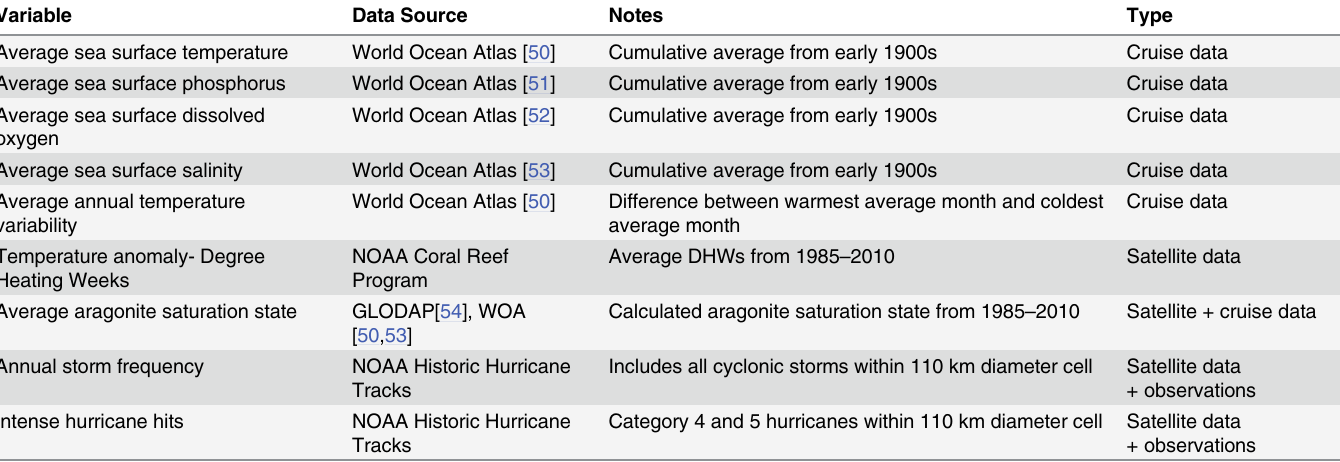
Table 1. Environmental variables used to determine unique coral reef habitats from 20 th century